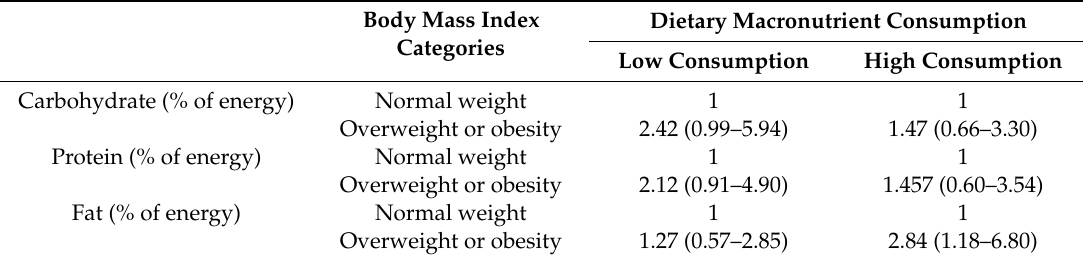
Table 4. Adjusted odds ratio for experiencing climacteric symptoms, according to body mass index categories and dietary macronutrient